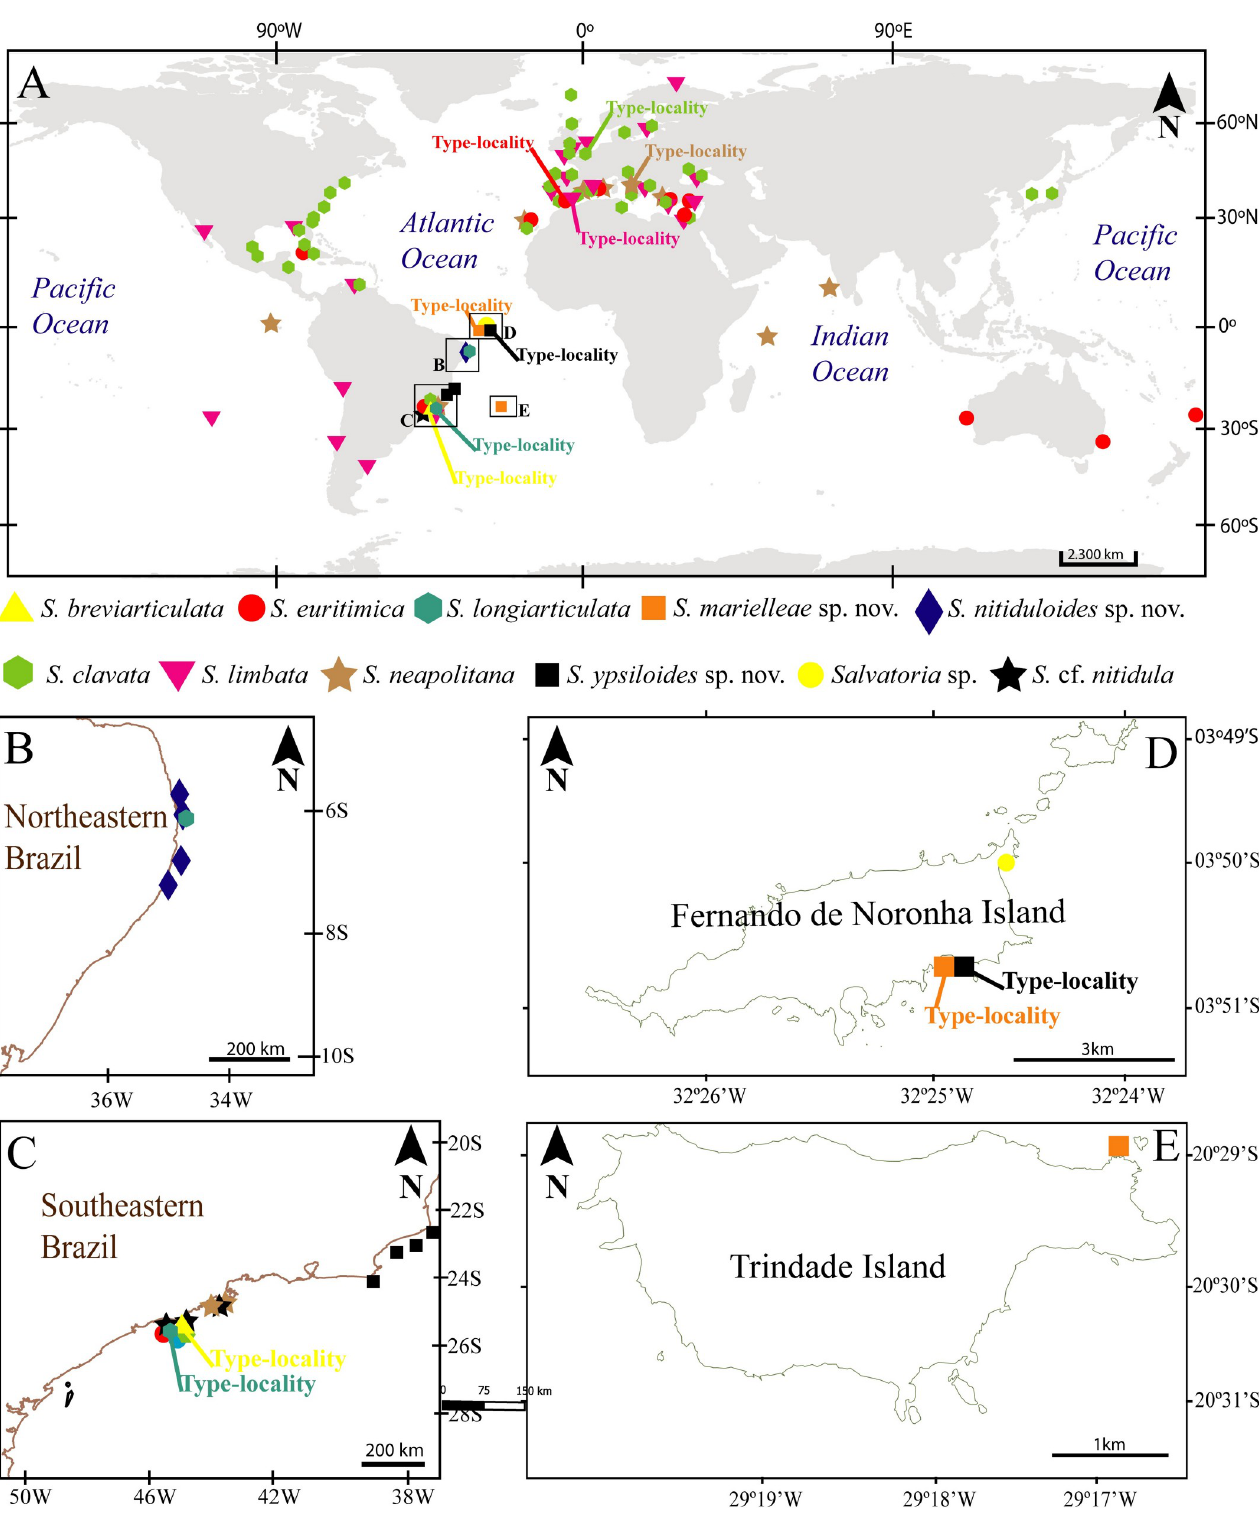
Fig 1. Distribution of the species of Salvatoria dealt with in the present paper. A, worldwide distribution records for the Salvatoria species registered in Brazil; B, C, species occurring on the Northeastern and Southeastern Brazilian coasts, respectively; D, E, species occurring on Fernando de Noronha and Trindade Islands,